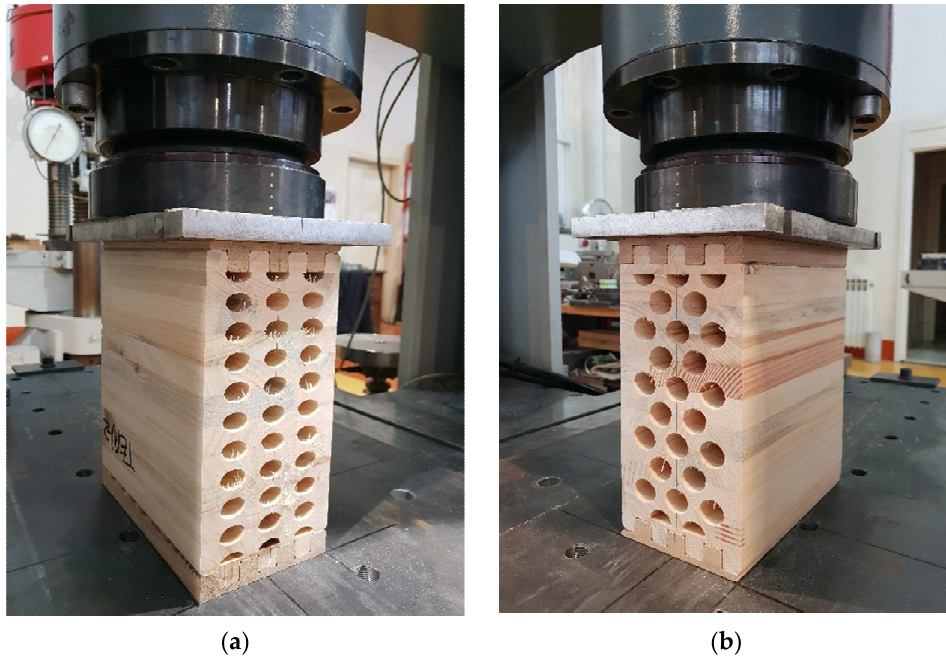
Figure 18. Timber samples during experimental test of compresion strength perpendicular to grain in the direction of weaker axis. ( a ) elliptical cavities; ( b ) circular cavities.